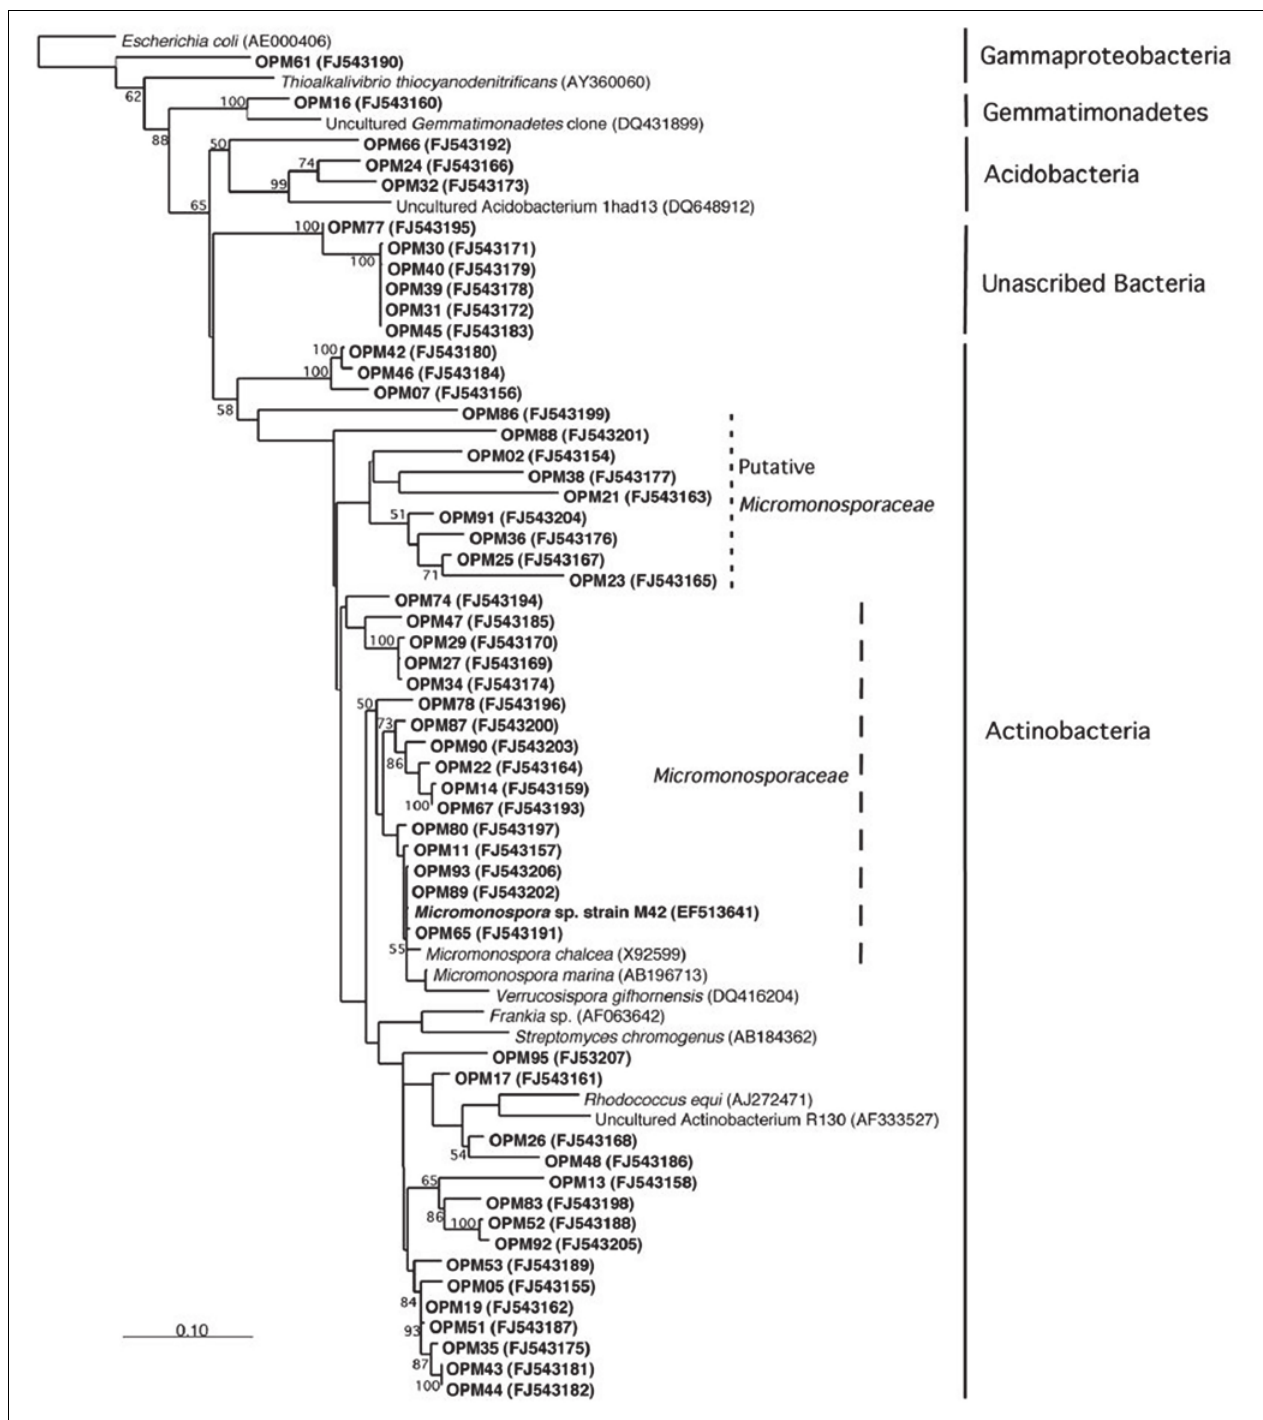
FIGURE 11 | Increased amplification of actinobacteria. Using a universal primer as well as an actinobacteria primer resulted in a higher amplification of actinobacteria 16s RNA. This result is consistent with those published by Farris and Olson